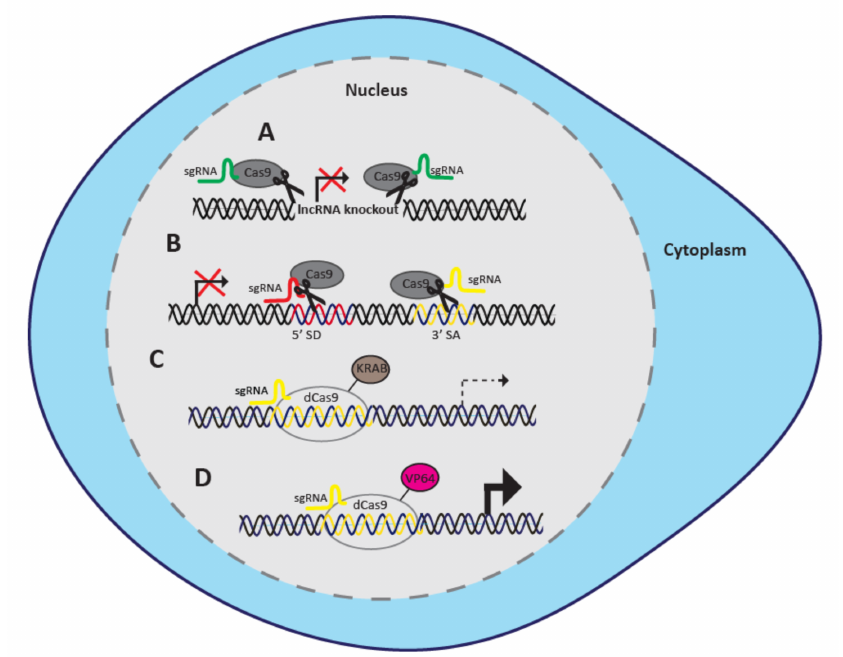
Figure 1. Methods for genomic and transcriptional targeting. ( A ) Paired-guide RNAs recruit Cas9 to the target lncRNA gene resulting in a complete knockout. ( B ) SgRNAs direct Cas9 to the splice sites of lncRNA genes resulting in complete knockout. ( C ) A sgRNA tethers dCas9-KRAB to the TSS resulting in gene knockdown. ( D ) A sgRNA guides dCas9-VP64 to the TSS resulting in transcriptional